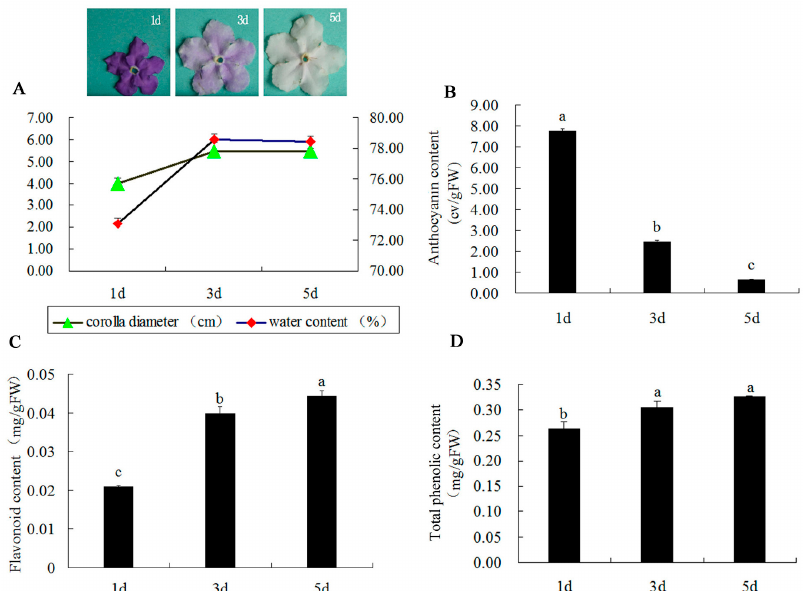
Figure 1. Changes of corolla diameter, water content, anthocyanin content, flavonoid content, and total phenolic content of B. acuminata petals. The different petals during anthocyanin degradation and the corolla diameter and water content changes after flower opening in petals ( A ); the contents